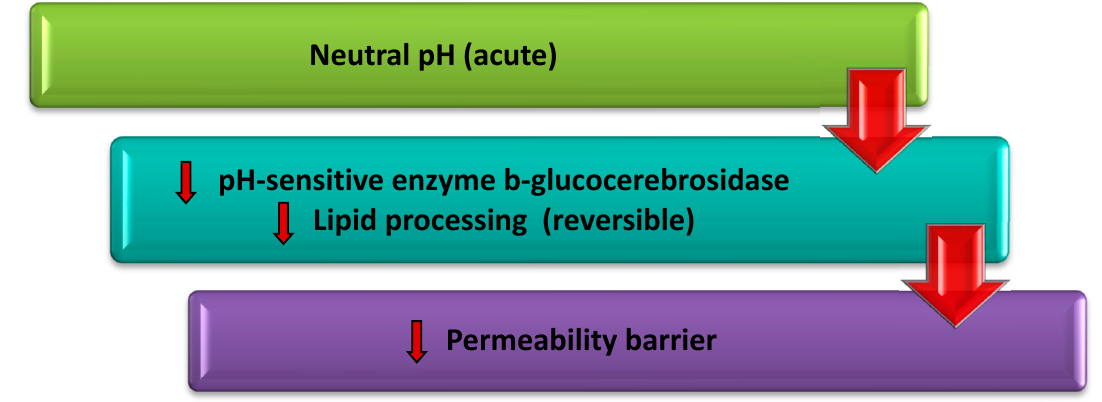
Figure 2. The e ff ect of skin pH change on permeability Figure 2. The effect of skin pH change on permeability barrier.